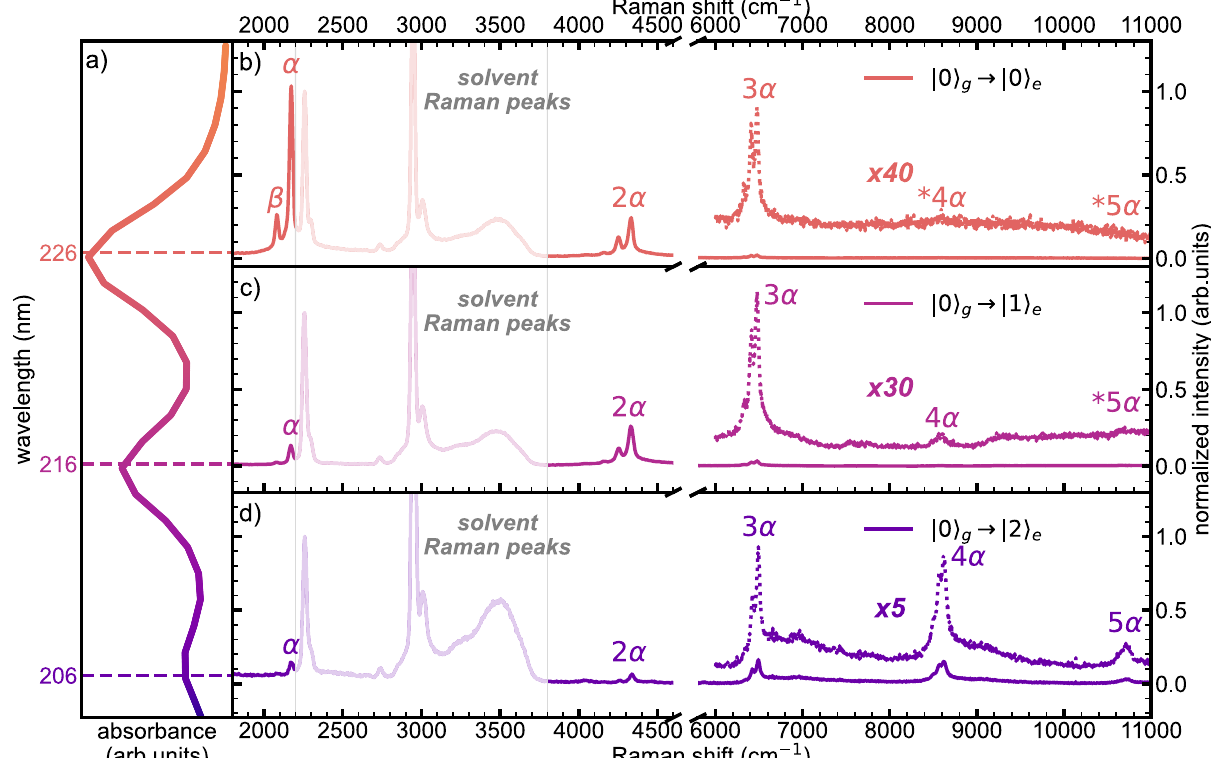
Fig.1|UV-VisabsorptionspectrumandUVresonanceRamanspectraofC 8 . UV- Visabsorptionspectrum(panel a )andUVresonanceRamanspectraofC 8 ,excited using synchrotron radiation at three different wavelengths: 226nm ( ∣ 0 i g ! ∣ 0 i e , b ), 216nm ( ∣ 0 i g ! ∣ 1 i e , c ), and 206nm ( ∣ 0 i g ! ∣ 2 i e , d ). The signals